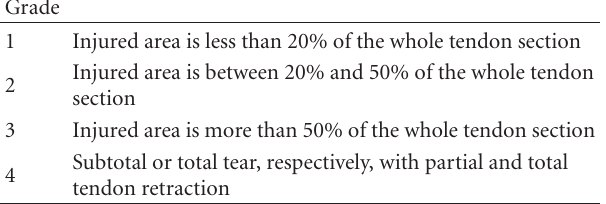
Table 1: Sonographic grading of the patellar tendinopathy. Grade ratio between injured area and whole tendon section at US scan.